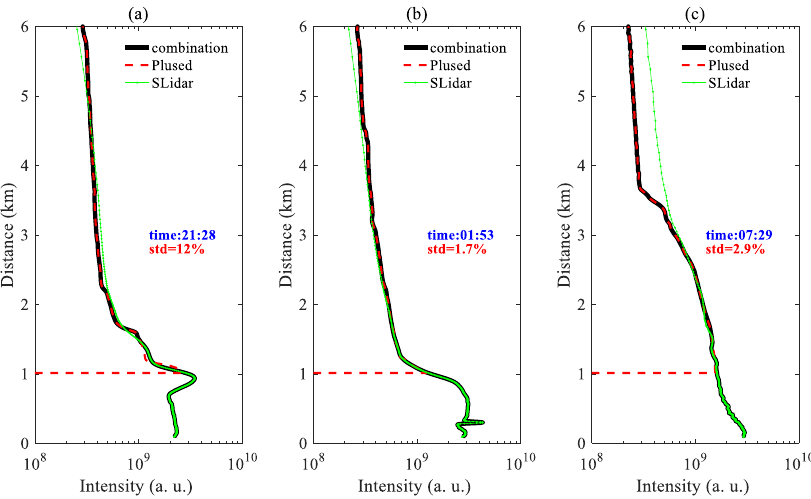
Figure 9. Combination of the lidar curves measured by the pulsed lidar system and the SLidar system at ( a ) 21:28, ( b ) 01:53, and ( c ) 07:29.